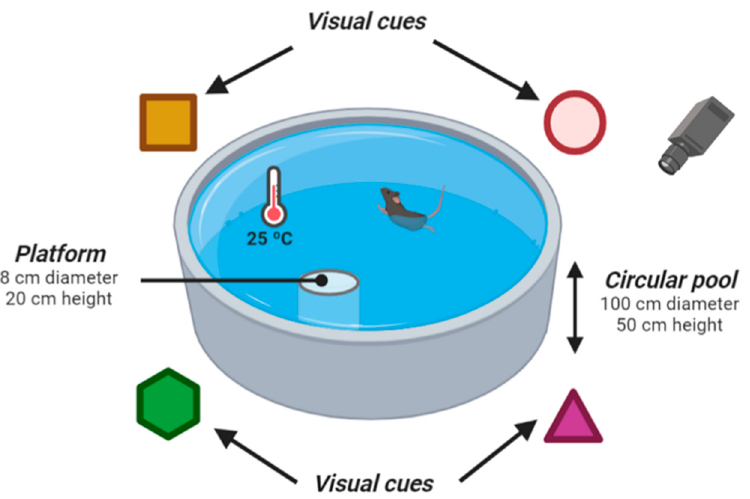
Figure 6. Characteristics of the Morris Water Maze. The test consists of a circular pool (100 cm in diameter) filled with water (at 25 °C) and a circular platform (8 cm in diameter, 20 cm in height) placed in a specific zone of the pool. The pool was virtually divided into four different quadrants and different visual clues were located on the walls of the room. All sessions were recorded with a video monitoring system that overlooks the pool from above. Figure created by BioRender.com.